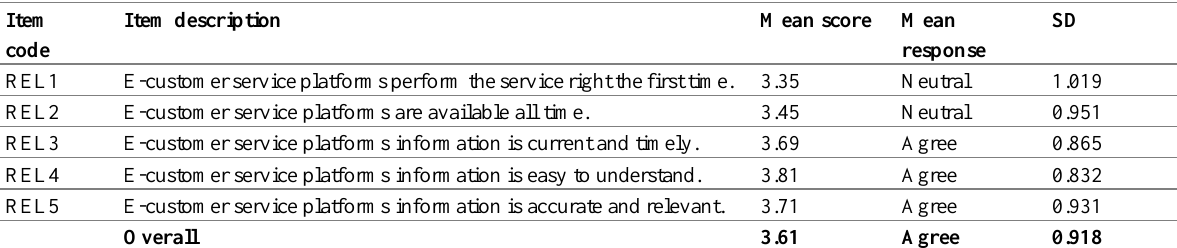
Table 3: Descriptive Statistics for